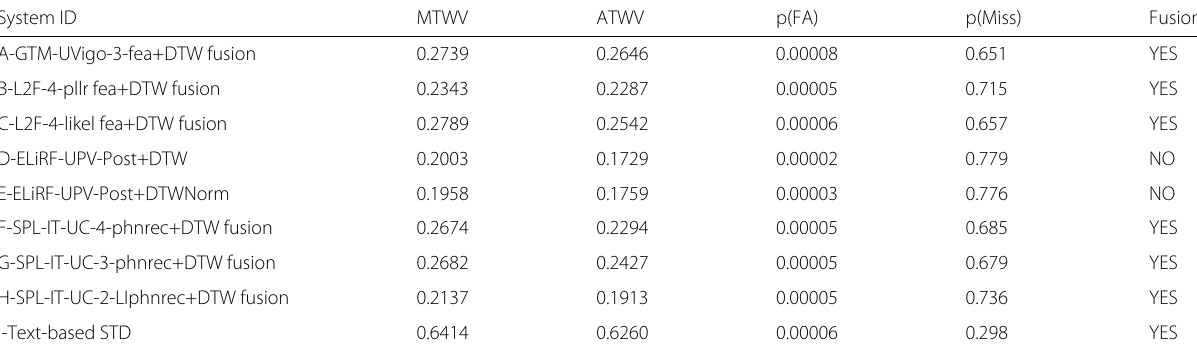
Table 10 System results of the ALBAYZIN QbE STD 2016 evaluation on the MAVIR test data System ID